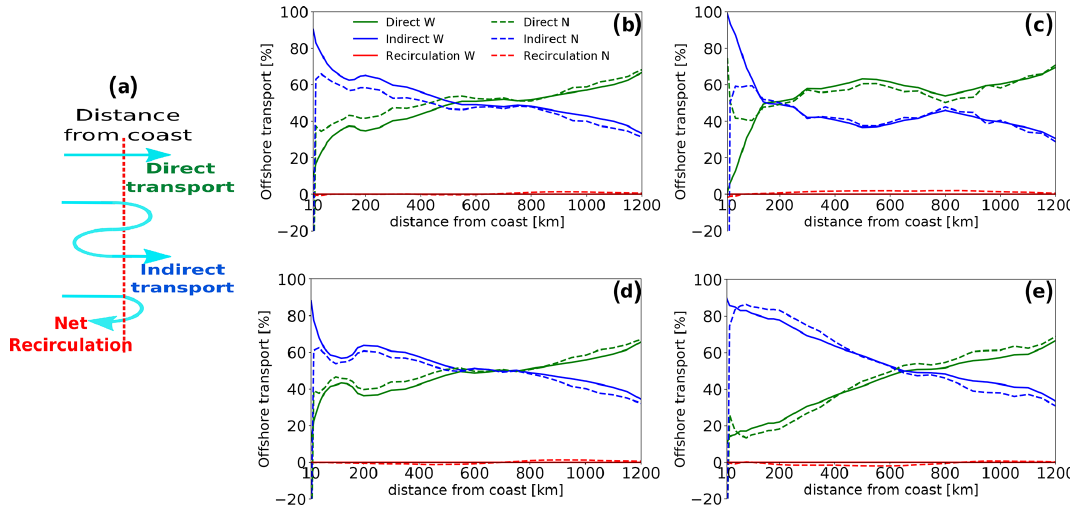
Figure 10. (a) Schematic showing the three types of offshore transport trajectories. (b, c, d, e) Contribution (in %) of direct transport (green), indirect transport (blue) and net recirculation (red) to the total net offshore transport of water (solid) and nitrogen (dashed) at each distance to the coast in the entire CanCS region (b) as well as the southern (c) , central (d) and northern (e) subregions. Note that the net recirculation has no contribution to net offshore water transport but contributes slightly to the net offshore transport of